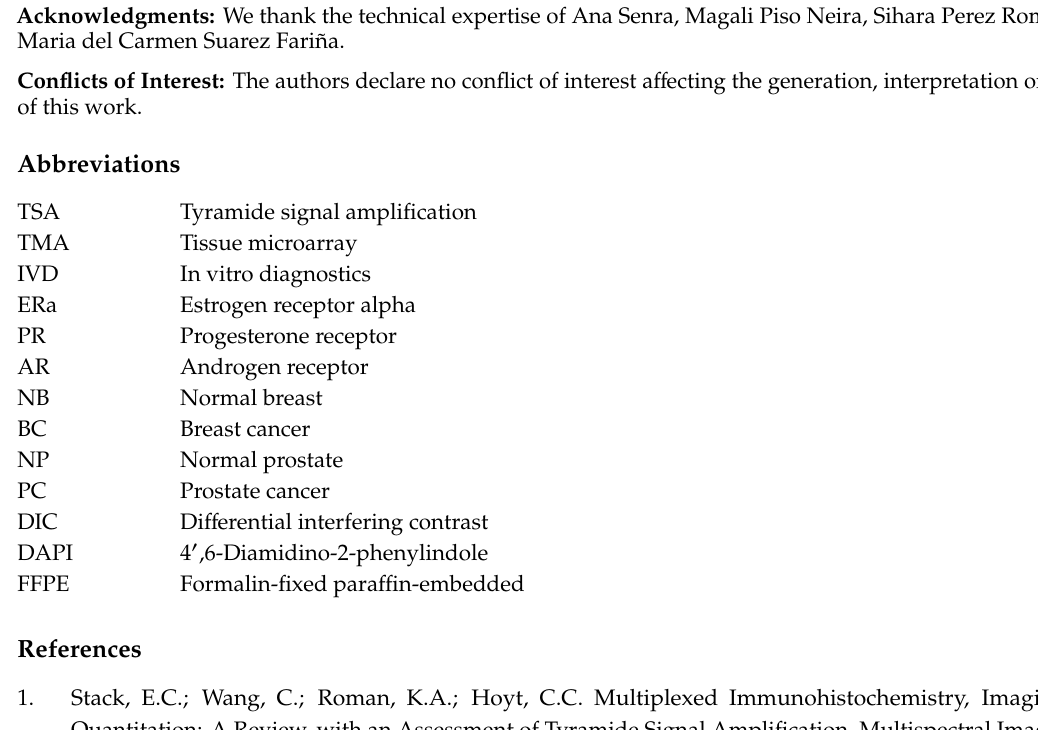
Figure S1: Standardization of the IHCF using human thyroid sections; Figure S2: Quantification of ColNu mIHCF in the epithelial (left and centre) and stromal compartments (right); Figure S3: Signal from each individual channel obtained through ColNu mIHCF from breast cancer samples using confocal microscopy; Figure S4: ColNu mIHCF in and array with four additional triple negative breast cancer cases; Figure S5: Signal from each individual channel obtained through ColNu mIHCF from prostate cancer samples using confocal microscopy; Table S1: Paired normal breast and breast cancer cases used in TMA; Table S2: Paired normal prostate and prostate cancer cases used in TMA; Table S3: Needle-core biopsy samples; Table S4: Antibodies used in this work, including those clinically validated for In Vitro Diagnostic (IVD). Fluorophores, channels and conditions for sequentially registering at the confocal. Extended Methods: detailed ColNu mIHC